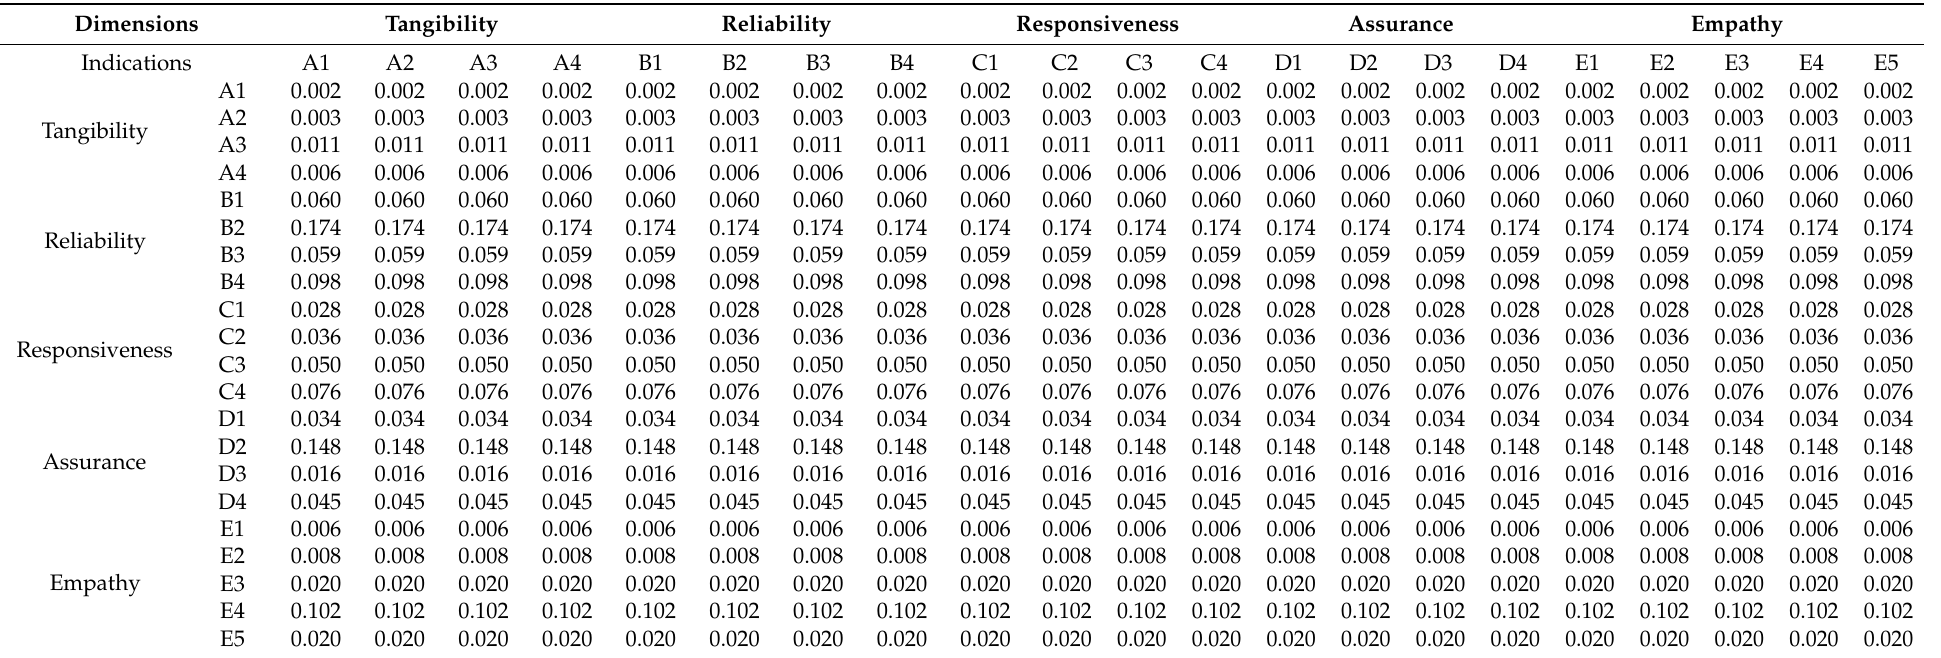
Table 7. The super matrix of comprehensive consumers’